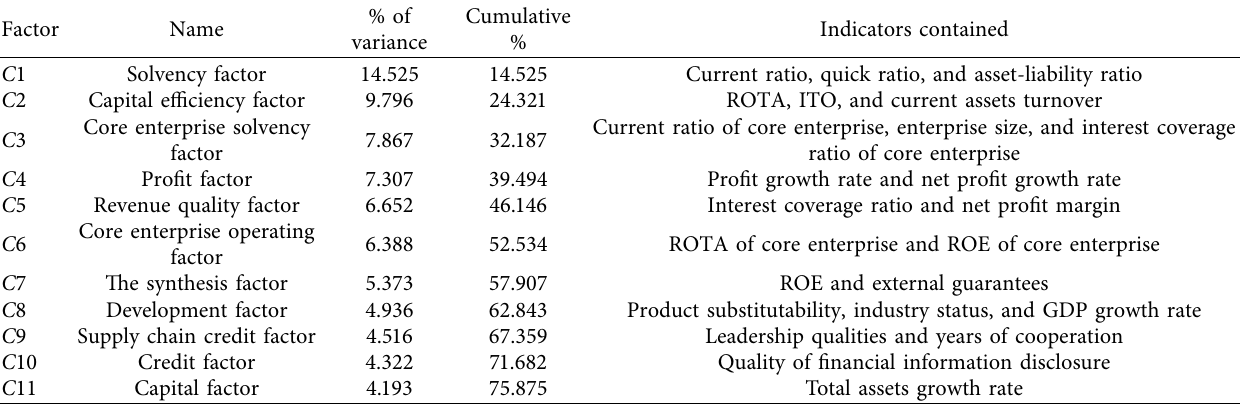
Table 7: Factor explanation table (pharmaceutical industry).